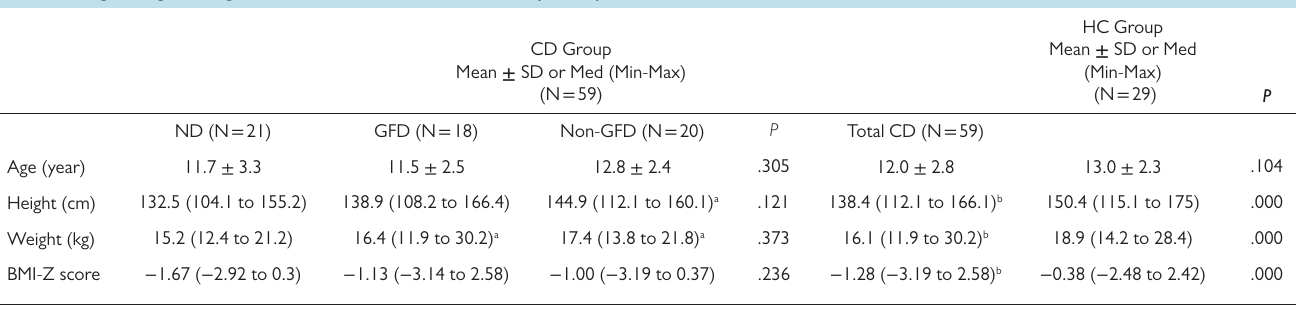
Table 1. Age, Height, Weight, and BMI-Z Score Data of the Study